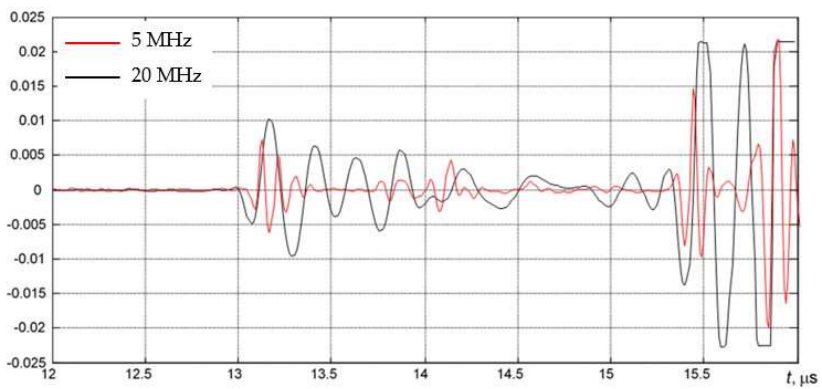
Figure 9. The waveforms of the received signals at the point AUBT-2 with 5 MHz (black) and 20 MHz (red) transducers.